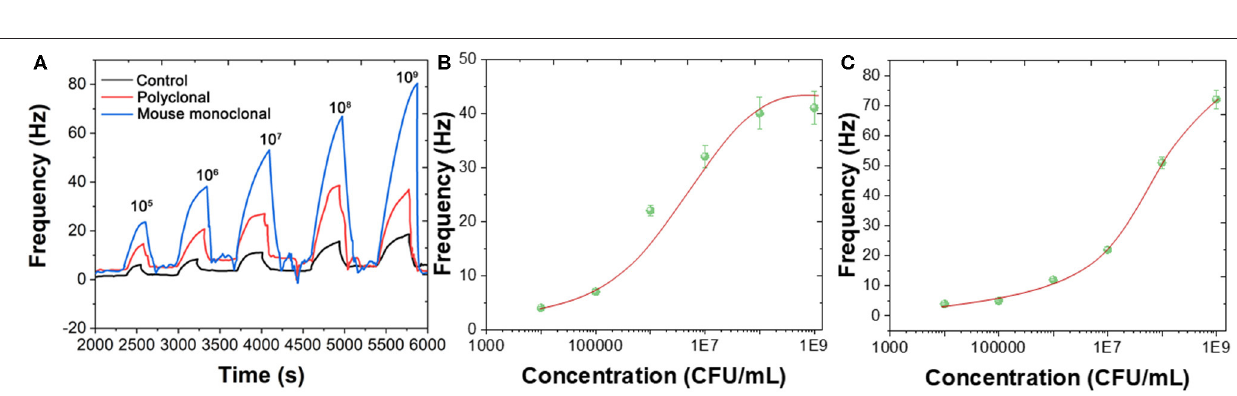
Frontiers in Chemistry | www.frontiersin.org